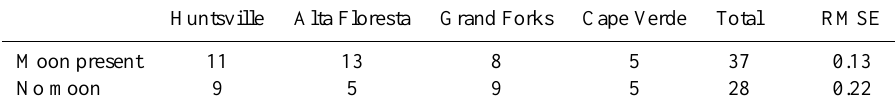
Table 2. RMSE of VIIRS-retrieved nighttime τ against straddling daytime-averaged AERONET τ for retrievals occurring on nights with (top) and without (bottom) the moon present. Nights with lunar presence are determined as those having a lunar fraction greater than 15% and having a lunar zenith angle less than 89 ◦ . The number of retrievals in each category separated by location is also shown. Huntsville Alta Floresta Grand Forks Cape Verde Total RMSE Moon present 11 13 8 5 37 0.13 No moon 9 28 0.22